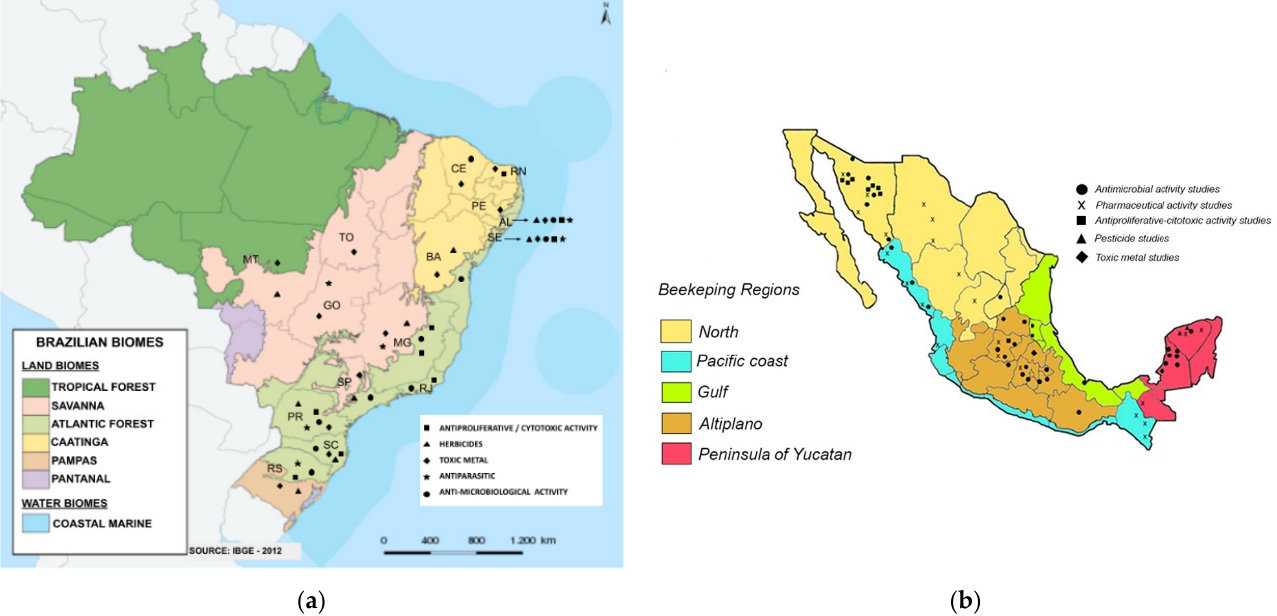
Figure 1. Maps with the biomes of ( a ) Brazil, beekeeping regions of ( b ) Mexico and the collection points of the different articles evaluated.